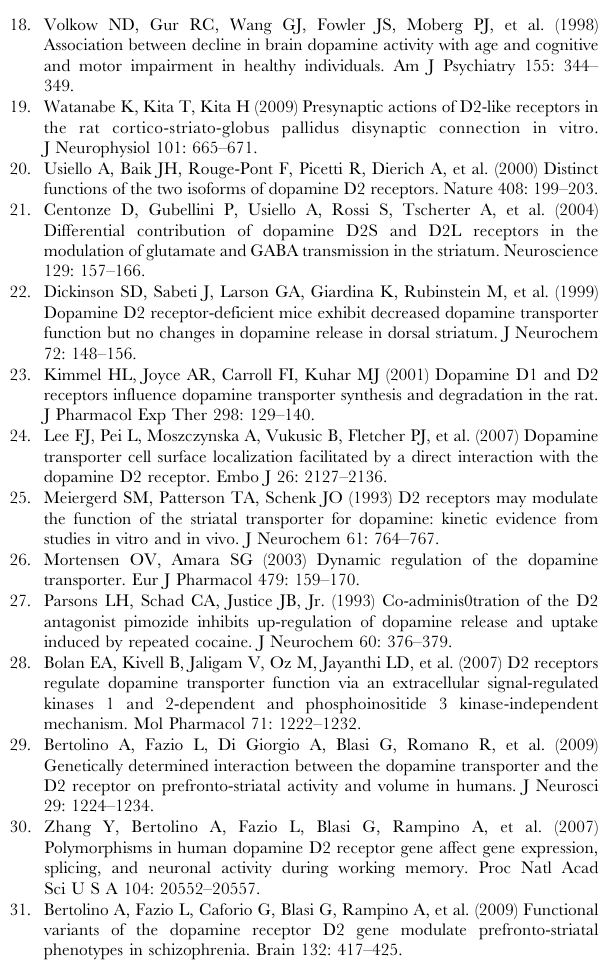
Figure S1 Relationship between behavioral performance and dopamine D2 signaling. Scatterplot of the non-linear relationship in GG subjects between working memory behavioral performance